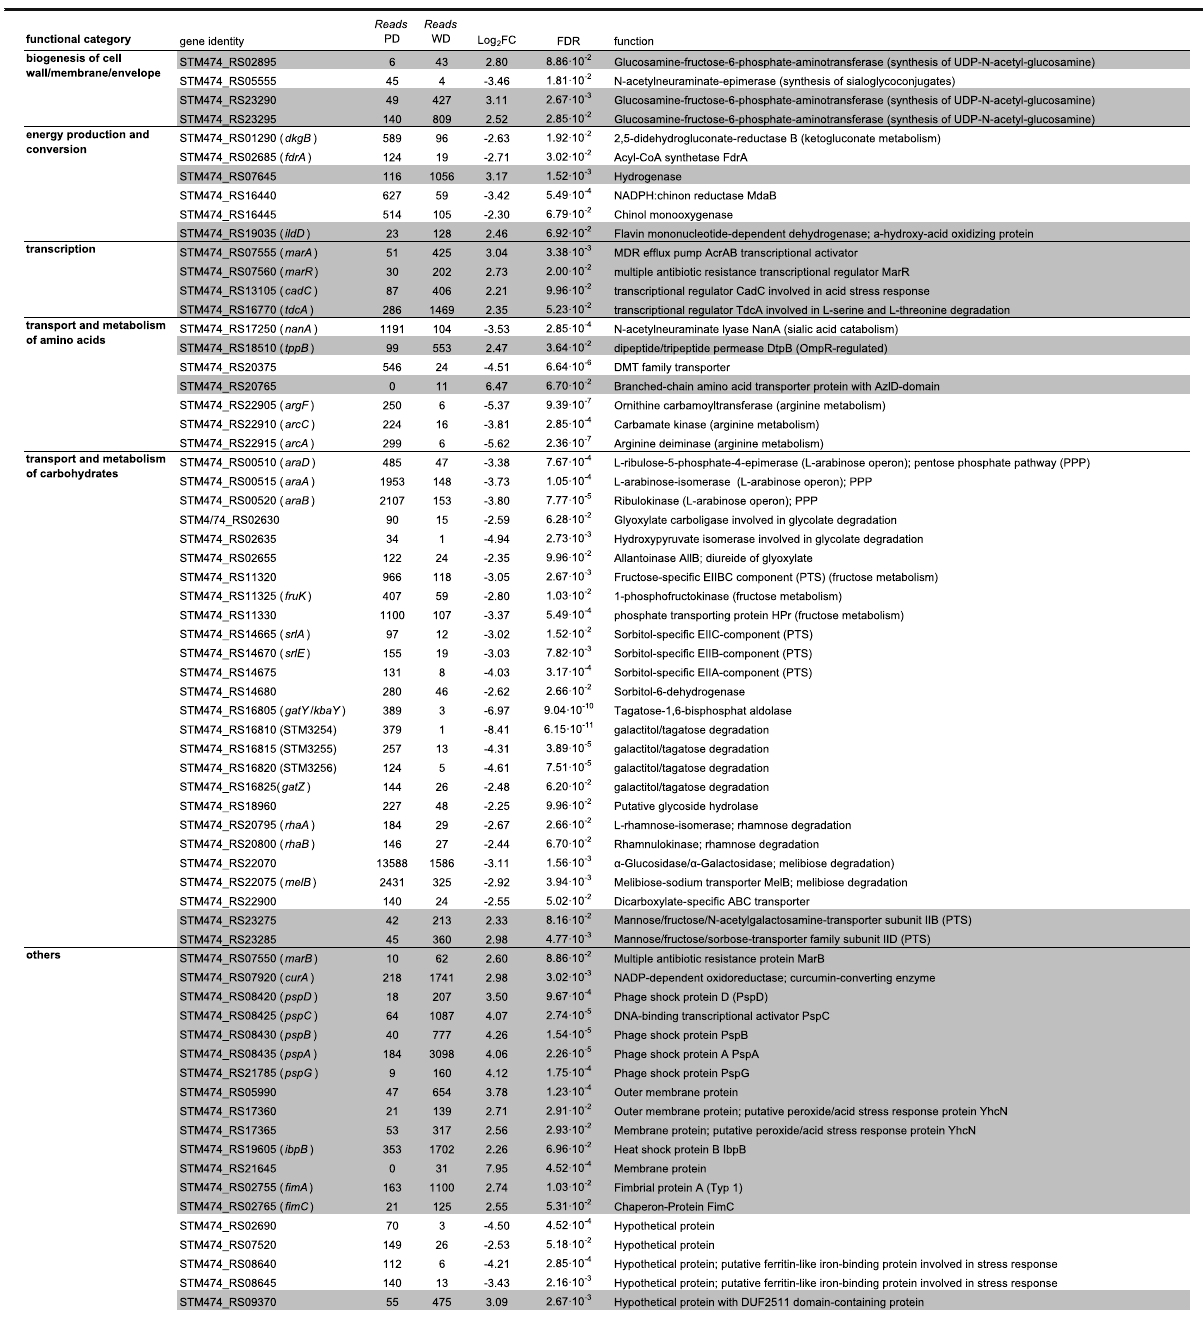
Table 1 Transcriptome analysis of strain ST4/74 isolated from mice fed WD or PD. FDR, false discovery rate. Positive log 2 fold- changes (FC) (gray) indicate a higher gene expression in WD fed mice in comparison with the PD fed group, negative FC (white) vice